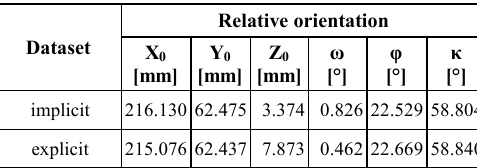
Table 6. Relative orientation of underwater bundle adjustment